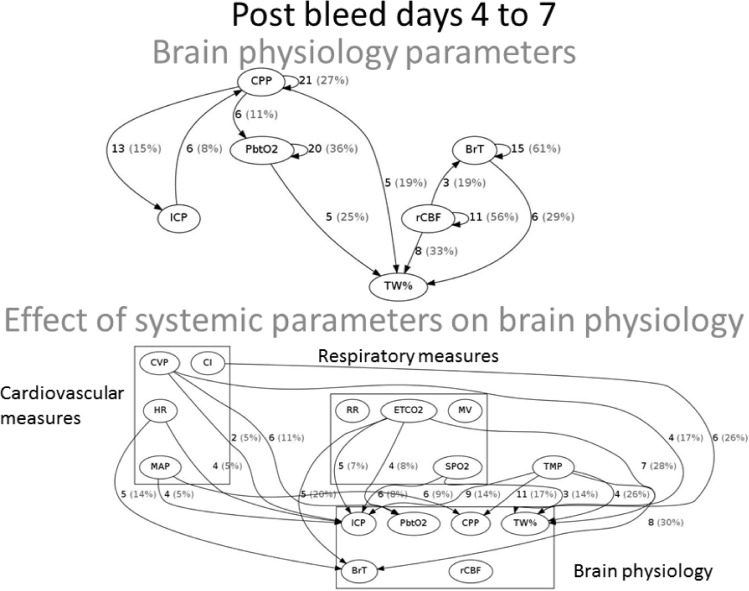
Brain physiology phase 2: Relationships within brain monitoring parameters (top row) and with systemic parameters (bottom row).